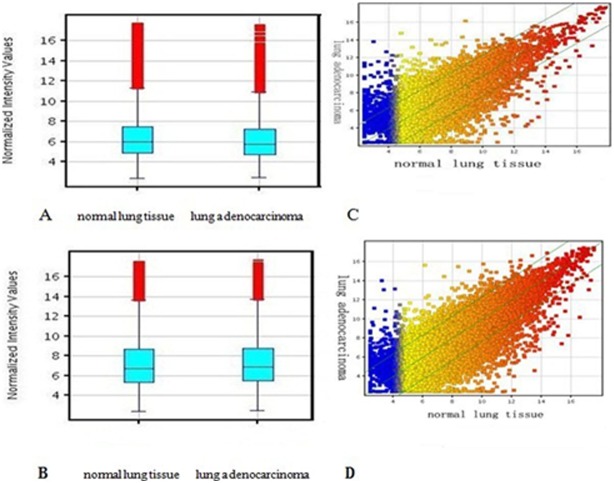
Box plots and Scatter plots showing the variation in lncRNA and mRNA expression between the lung adenocarcinoma and normal lung tissue arrays.(A–B) Box plots showing the distribution of the lncRNA (A) and mRNA (B) profiles. After normalization, the distributions of the log2-ratios among the tested samples were nearly the same. (C–D) Scatter plots showing the variation in lncRNA (C) and mRNA (D) expression between the lung adenocarcinoma and normal lung tissue arrays. The values of the X and Y axes in the scatter plot are averaged normalized values in each group (log2-scaled). The lncRNAs above the top green line and below the bottom green line are those with a >3-fold change in expression between tissues.